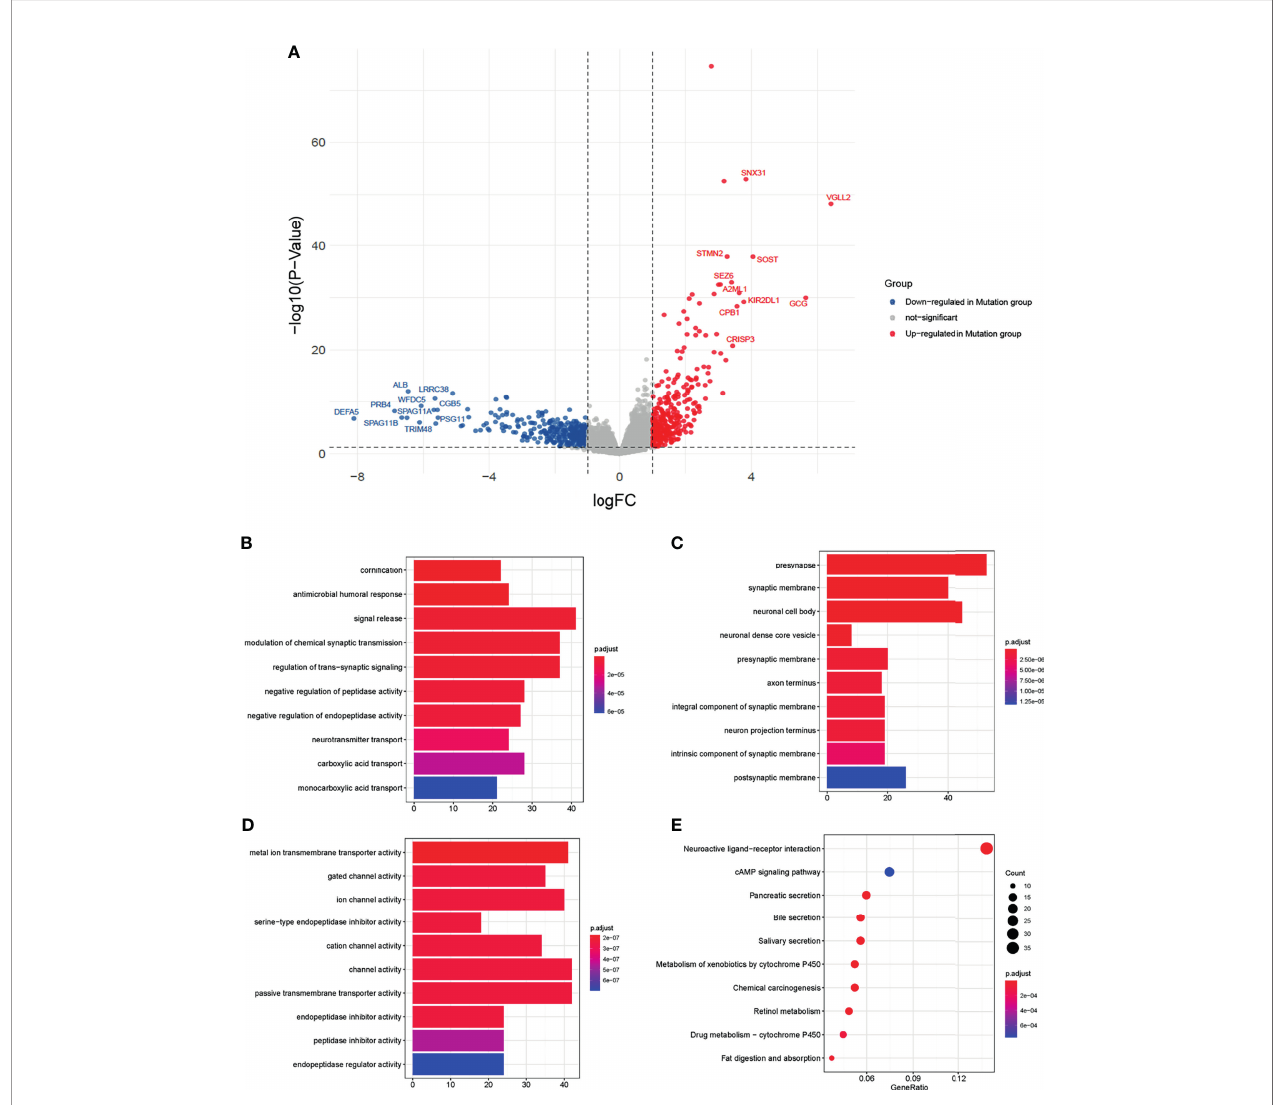
FIGURE 3 | Transcriptomics analysis of the two groups. (A) Volcano map of differentially expressed genes (DEGs) between the mutation and wild groups. Blue dots represented genes downregulated in the mutation group. Grey dots represent genes not signi fi cant between the two groups. Red dots represented genes upregulated in the mutation group. (B – D) Barplots of the top ten signi fi cantly different biological processes (BP), cellular component (CC), and molecular function (MF) by Gene Ontology (GO) enrichment analysis. (E) Dot plot of the top ten signi fi cantly different enrichment pathways by Kyoto Encyclopedia of Genes and Genomes (KEGG)